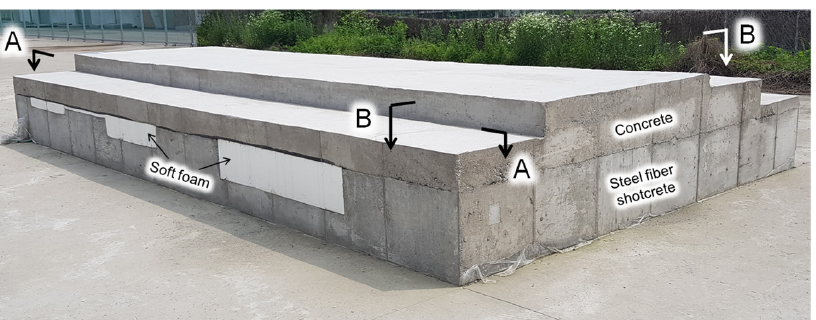
Figure 2. Photograph presenting overall view of the concrete tunnel lining concrete model specimen fabricated and used for GPR survey in this study.